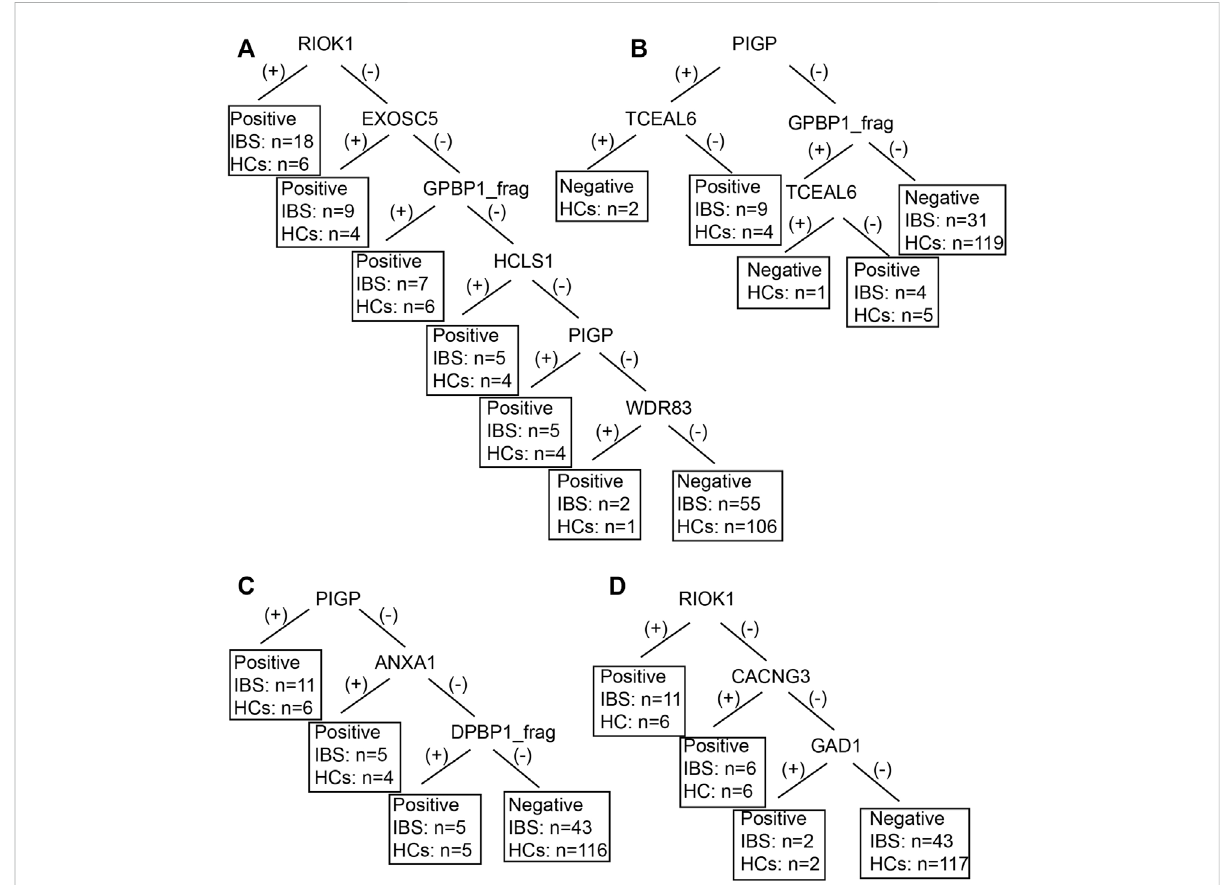
FIGURE 4 The decision tree models of IgA between IBS subgroup patients and HCs. Negative refers to healthy control can be diagnosed. (A) IBS patients with persistent symptoms and HCs. Positive refers to IBS with persistent symptoms can be diagnosed. (B) IBS patients with severe abdominal pain/ discomfortandHCs.PositivereferstoIBSwithsevereabdominalpain/discomfortcanbediagnosed. (C) IBSpatientswithseveresymptomsandHCs. Positive refers to IBS with severe symptoms can be diagnosed. (D) IBS patients with severe anxiety and HCs. Positive refers to IBS with severe anxiety can be